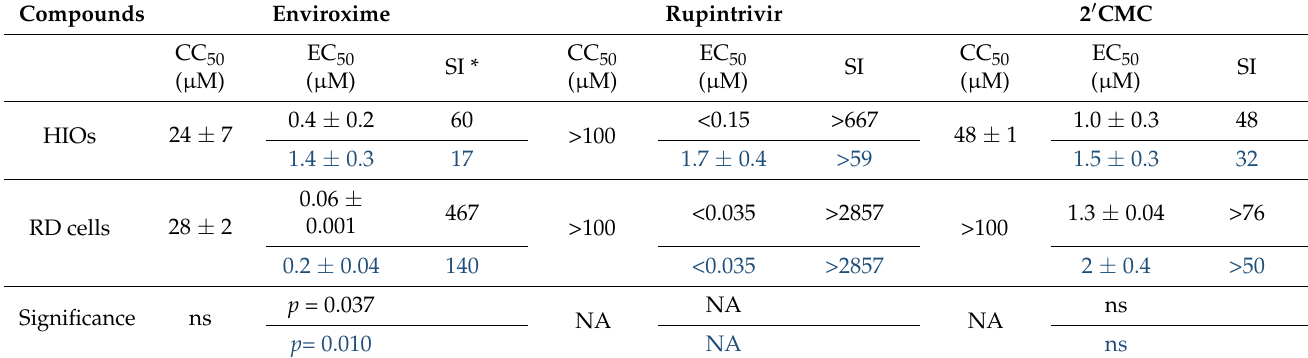
Table 1. CC 50 , EC 50 , and selectivity indices of enviroxime, rupintrivir, and 2 (cid:48) CMC in HIOs and RD